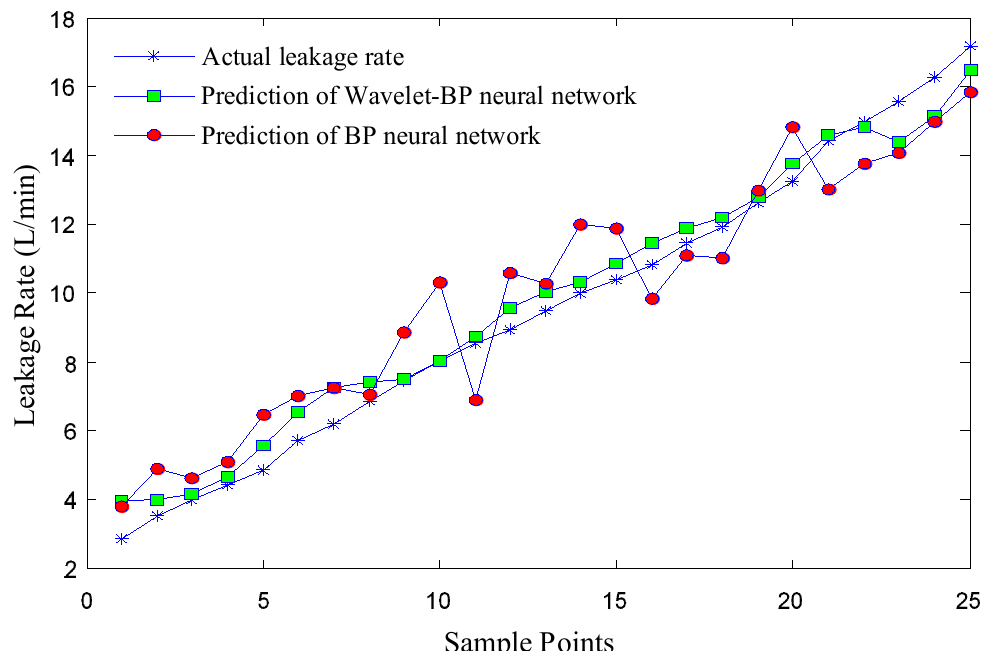
Figure 9. The influence of the wavelet decomposition on model prediction results.